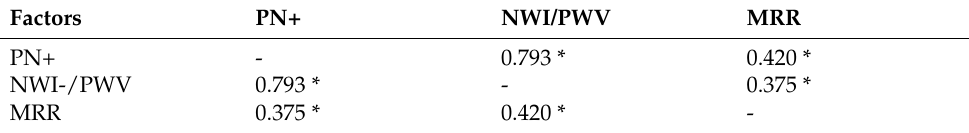
Table 3. Pearson correlations between factors, n =